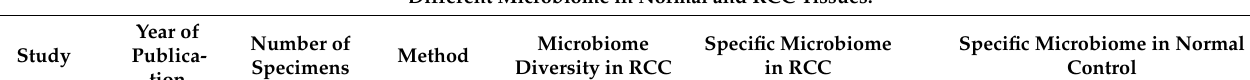
Table 1. Comprehensive summary of microbiome studies in RCC. Different Microbiome in Normal and RCC